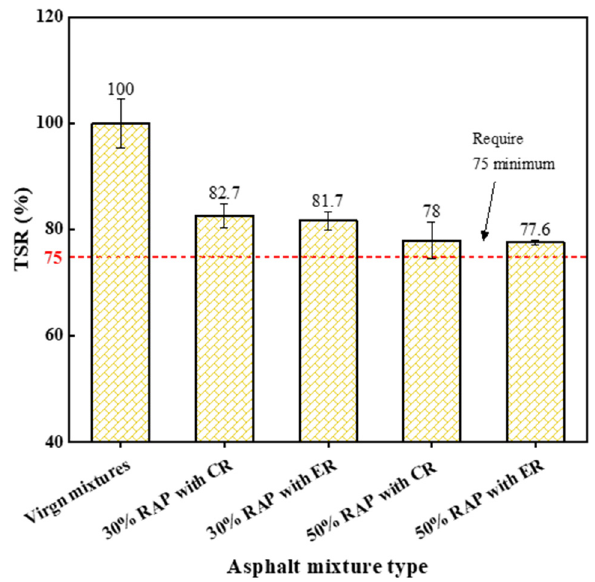
Figure 9. The tensile strength ratio (TSR) results of each studied mixture.